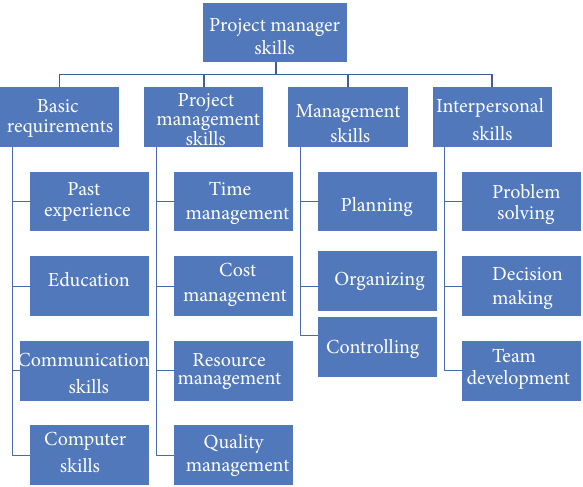
Figure 3: The hierarchical structure for project manager selection.